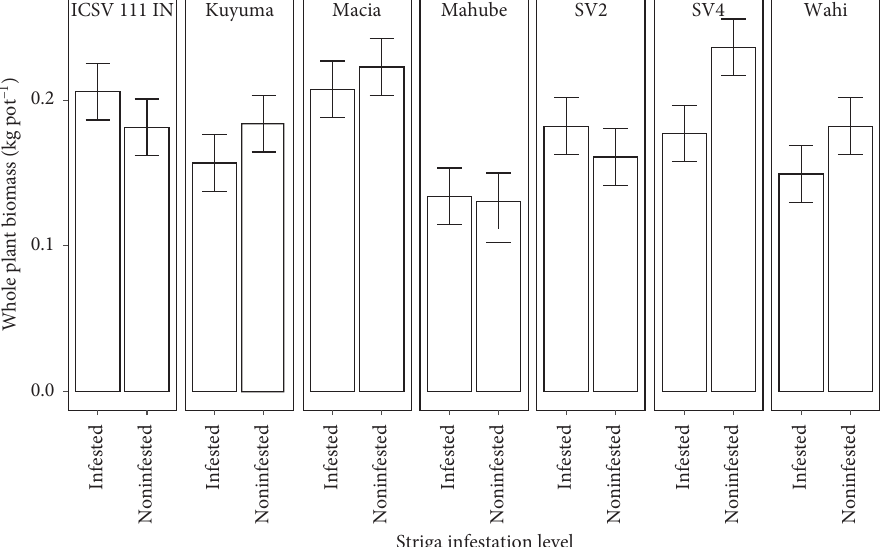
Figure 9: Effect of genotype and Striga infestation on sorghum whole plant biomass (kg pot − 1 ). Error bars represent LSD at p < 0 .